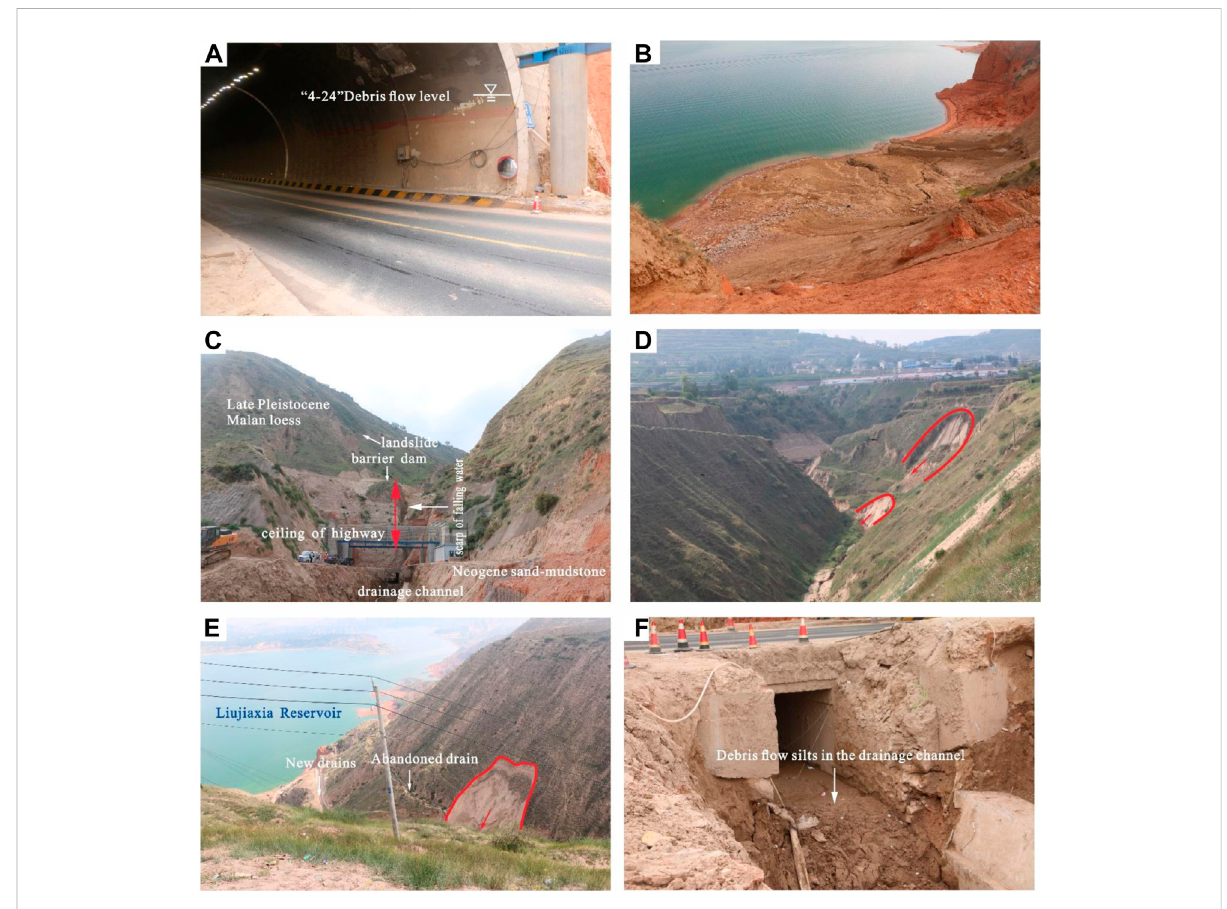
FIGURE 5 Debris fl ow characteristics and treatment engineering measures applied in Zhangjiayuan gully (A) Mud level at the west entrance of Tunnel 408lens:NE;Generalviewofthecirculationareaanddebris fl owoutlet:SEE; (B) Debris fl owdepositionalarealens:NE; (C) .Landslidesthatoccurred ontheleftbankofthegullyupstream(H-06)lens:S; (D) Landslideontherightbankinthetransportationarealens:NE; (E) Culvertunderthehighway lens: SE; (F) Retaining wall upstream of the culvert lens: SE.